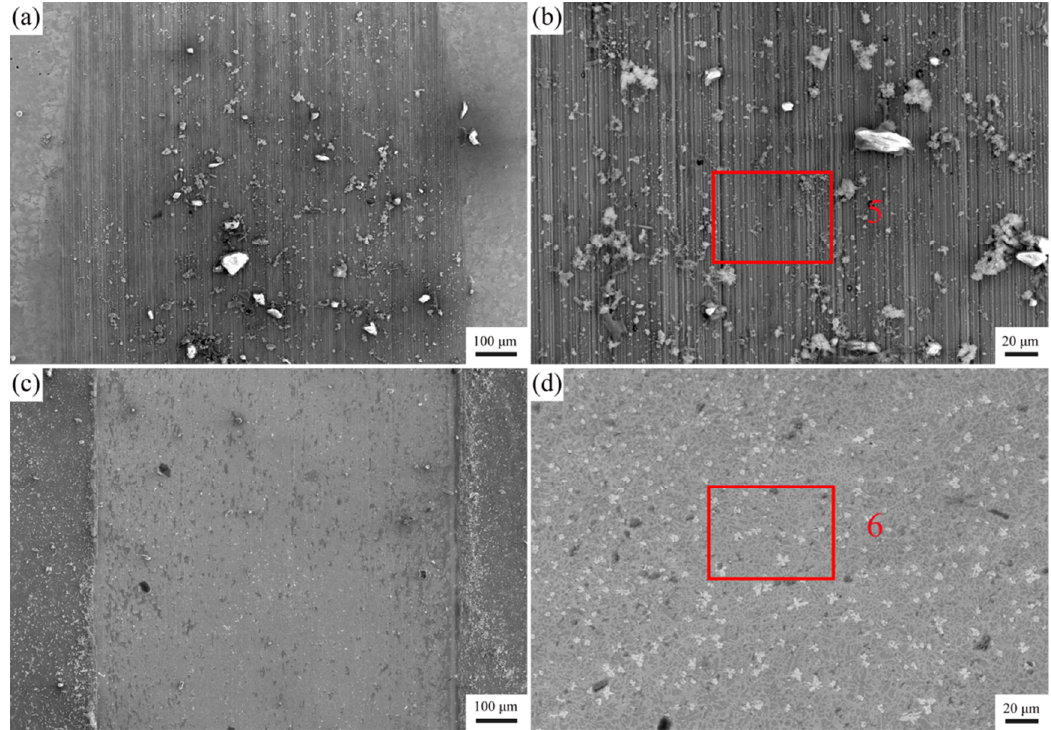
Figure 11. Wear tracks of the substrate (( a ) and ( b )) and Coating III (( c ) and ( d )) subject to friction in 3.5 wt.% NaCl solution.